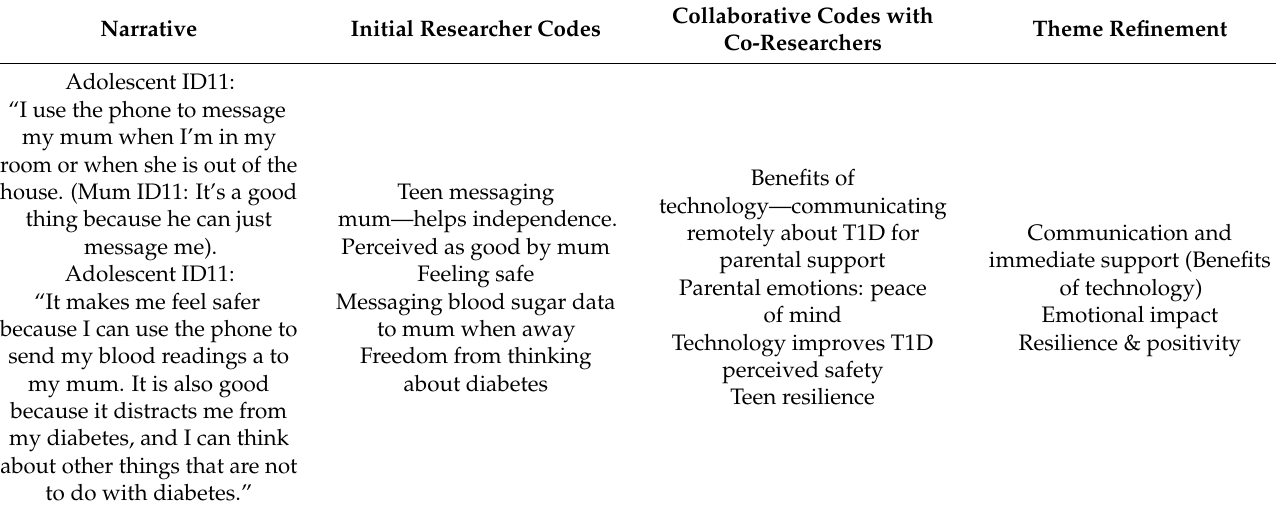
Table 2. Initial coding example with data excerpt ID11 is shown in Figure